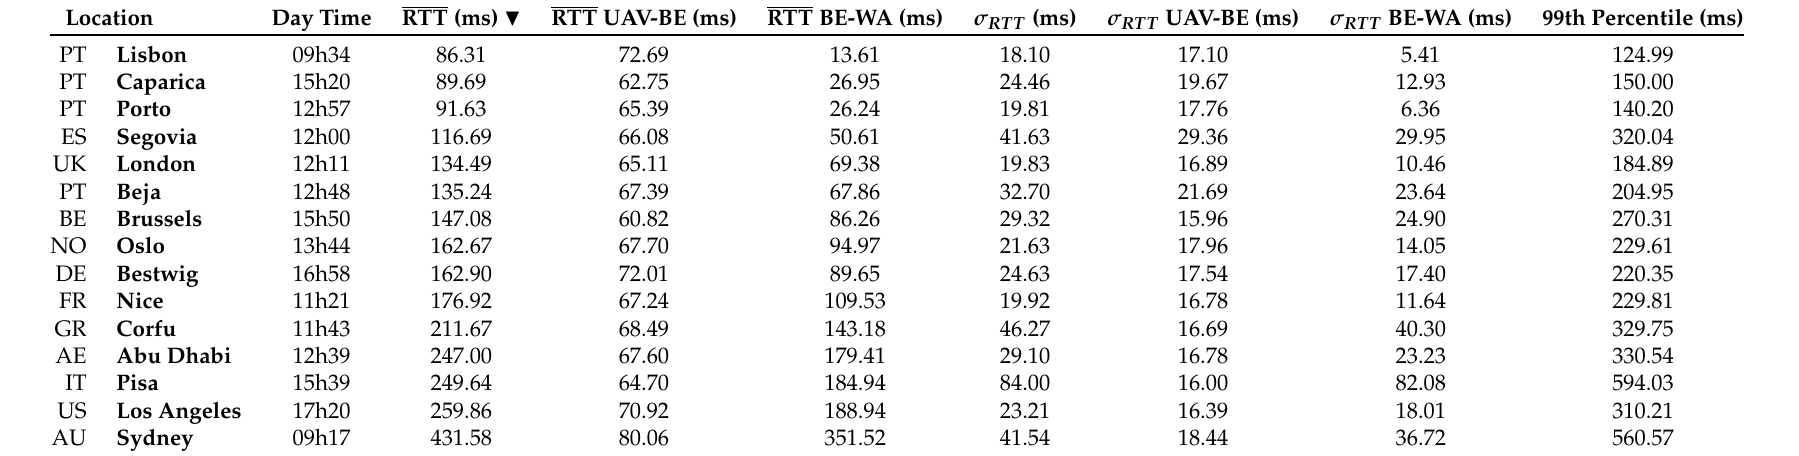
Table 2. RTT between the UAV and the Beyond Skyline platform analyzed by varying the web application